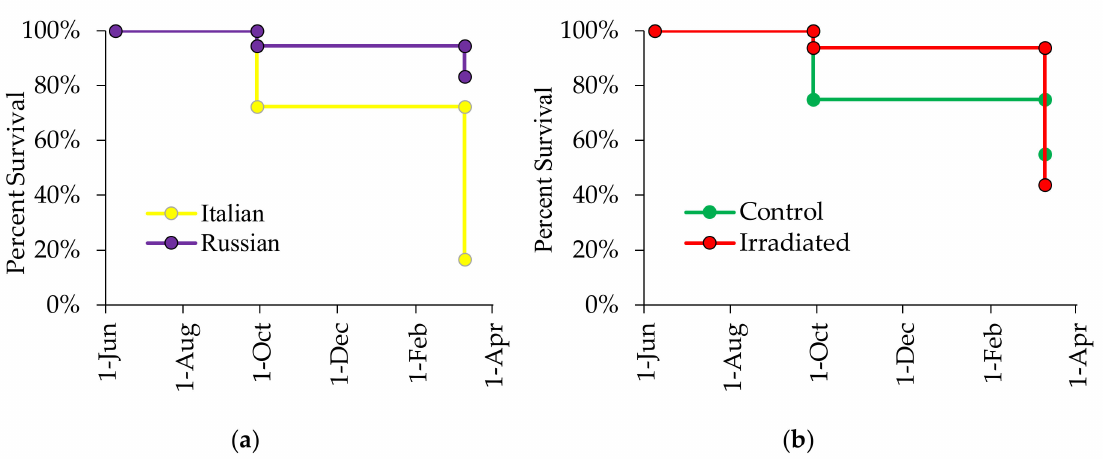
Figure 10. Effects of honey bee stock ( a ) and comb irradiation ( b ) on colony survival in